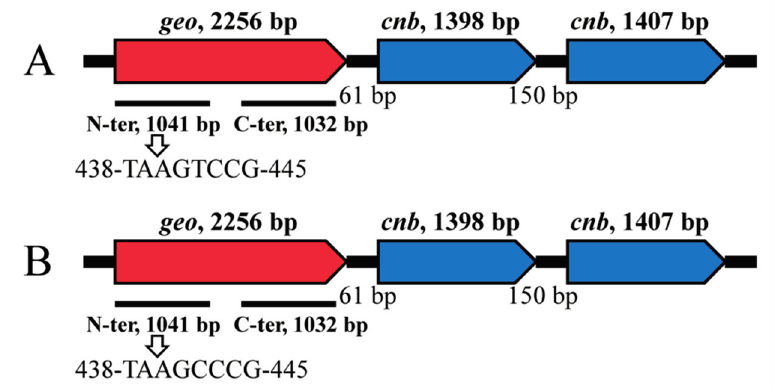
Figure 2. Geosmin synthesis genes of A. ucrainica . ( A ) Strain CHAB 1432; ( B ) strain CHAB